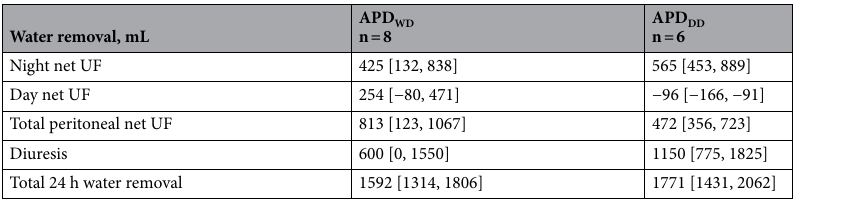
Table 3. The overall water removal (net UF, median [Q 1 , Q 3 ] in mL) from night APD exchanges and the long daytime exchange, diuresis and total 24 h water removal, measured in patients undergoing APD with wet day (APD WD ) or a dry day regime (APD DD ). No significant differences were found between APD DD and APD WD concerning the night and day net UF, total peritoneal net UF, diuresis and total 24 h water removal (p > 0.1; Mann–Whitney U test).